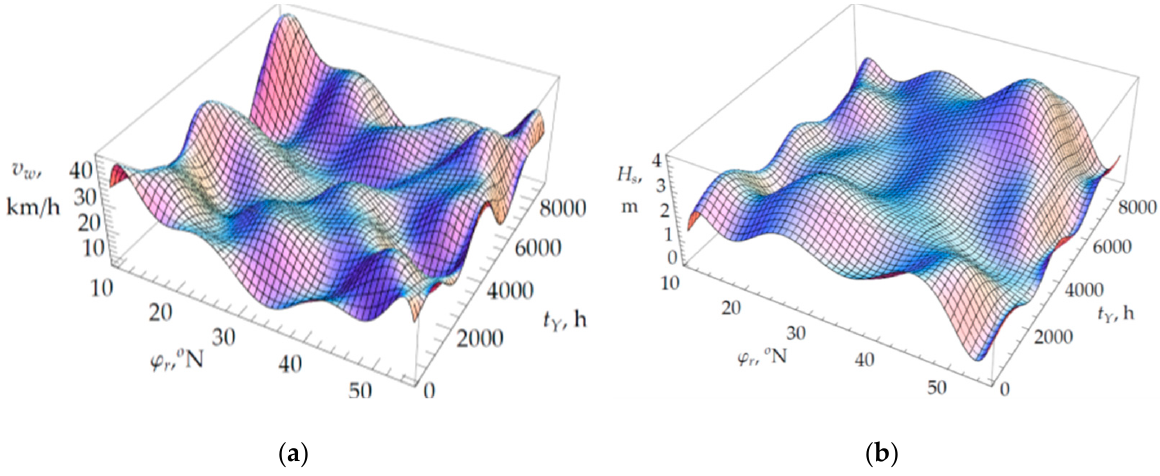
Figure 3. Air temperature models en route: ( a ) ϑ a